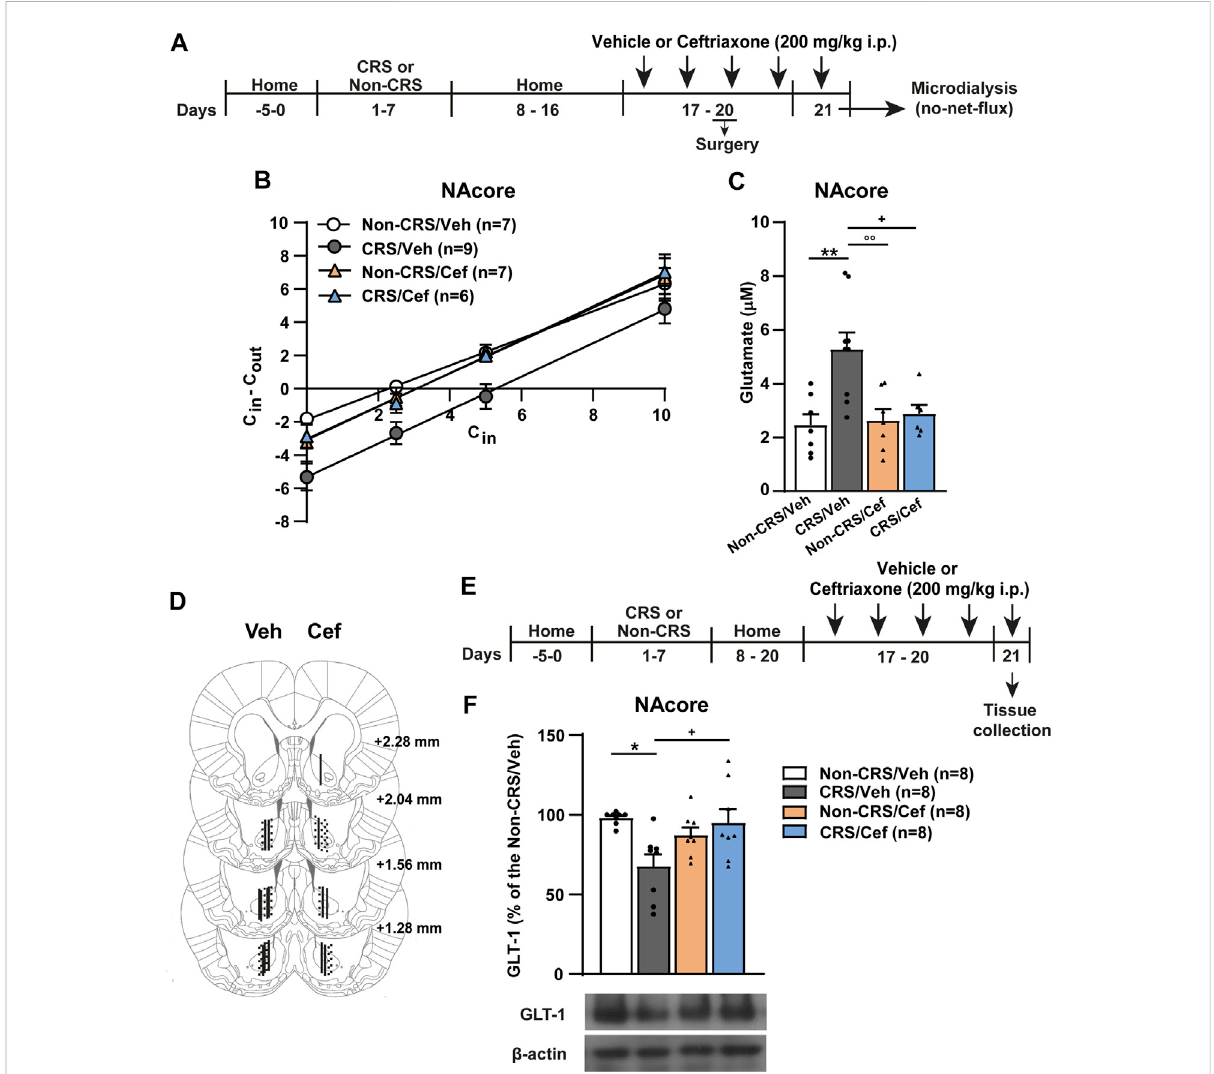
FIGURE 5 Ceftriaxone restored the CRS-induced GLT-1 downregulation and increased basal concentrations of extracellular glutamate in the NAcore. (A) Schematic timeline of the experimental protocol. (B) Fitted regression lines of no-net- fl ux microdialysis in the NAcore (slopes – Non-CRS/Veh: 0.82 ± 0.07, CRS/Veh: 1.01 ± 0.10, Non-CRS/Cef: 0.99 ± 0.12 and CRS/Cef: 1.01 ± 0.08). Linear regression analysis showed non-signi fi cant differences among the slopes of the regression line of no-net- fl ux plot (F (3,108) = 0.83; p = 0.48). (C) Data obtained from extrapolation from the regression line of each subject belonging each experimental group with x axis showed the following basal extracellular glutamate concentrations: Non-CRS/Veh (2.46 ± 0.41) µM, CRS/Veh (5.27 ± 0.63) µM, Non-CRS/Cef (2.62 ± 0.42) µM and CRS/Cef (2.87 ± 0.34) µM. Two-way ANOVA revealedsigni fi cantinteraction(Non-CRSvs.CRSxVehvs.Cef;F (1,25) =6.28, p < 0.05),signi fi canteffectofstress(Non-CRSvs.CRS;F (1,25) =8.90, p < 0.01) and ceftriaxone treatment (Veh vs. Cef; F (1,25) = 4.75, p < 0.05). Bonferroni post-hoc test showed signi fi cant differences comparing Non-CRS/ Veh with CRS/Veh (** p < 0.01) and CRS/Veh with CRS/Cef ( + p < 0.05). Ceftriaxone treatment did not evidence a per se effect on basal extracellular glutamate concentrations as shown comparing Non-CRS/Cef with CRS/Veh ( °° p < 0.01) and Non-CRS/Cef with Non-CRS/Veh (n.s.). (D) Illustration of the location of the active membrane of the dialysis probe in the NAcore and NAshell according to Paxinos and Watson (2007). Dashed lines represent probe placements in the Non-CRS group, solid lines those in the CRS group, lines shown in the left hemisphere correspond to the Veh group while lines in the right hemisphere correspond to the Cef group. (E) Schematic timeline of the experimental protocol. (F) In fl uence of ceftriaxone treatment onNAcore GLT-1content.Two-wayANOVArevealed signi fi cantinteraction(Non-CRSvs. CRSx Vehvs. Cef;F (1,28) =9.56, p < 0.01).Therewerenosigni fi canteffectsofstress(Non-CRSvs.CRS;F (1,28) =3.32,n.s.)ortreatment(Vehvs.Cef;F (1,28) =1.81,n.s.).Bonferroni post-hoc test showed signi fi cant differences comparing Non-CRS/Veh with CRS/Veh (* p < 0.05) and CRS/Veh with CRS/Cef (+ p < 0.05). Ceftriaxone treatment did not evidence a per se effect on basal extracellular glutamate concentrations as shown comparing Non-CRS/Cef with Non-CRS/Veh (n.s.). Data are shown as mean ± SEM. N is shown in brackets. (CRS, chronic restraint stress; Veh, vehicle; Cef, ceftriaxone; Sal, saline; Coc,